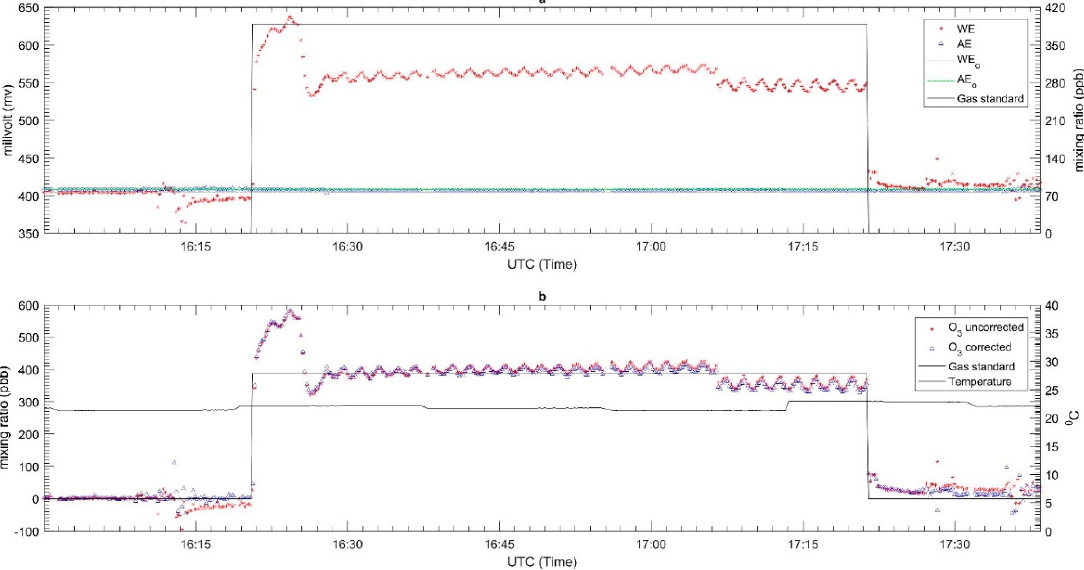
Figure 9. The laboratory calibration of OX-A431 EC sensor ( a ) the electrode signal along with the gas standard and ( b ) The signal converted to mixing ratio and temperature.